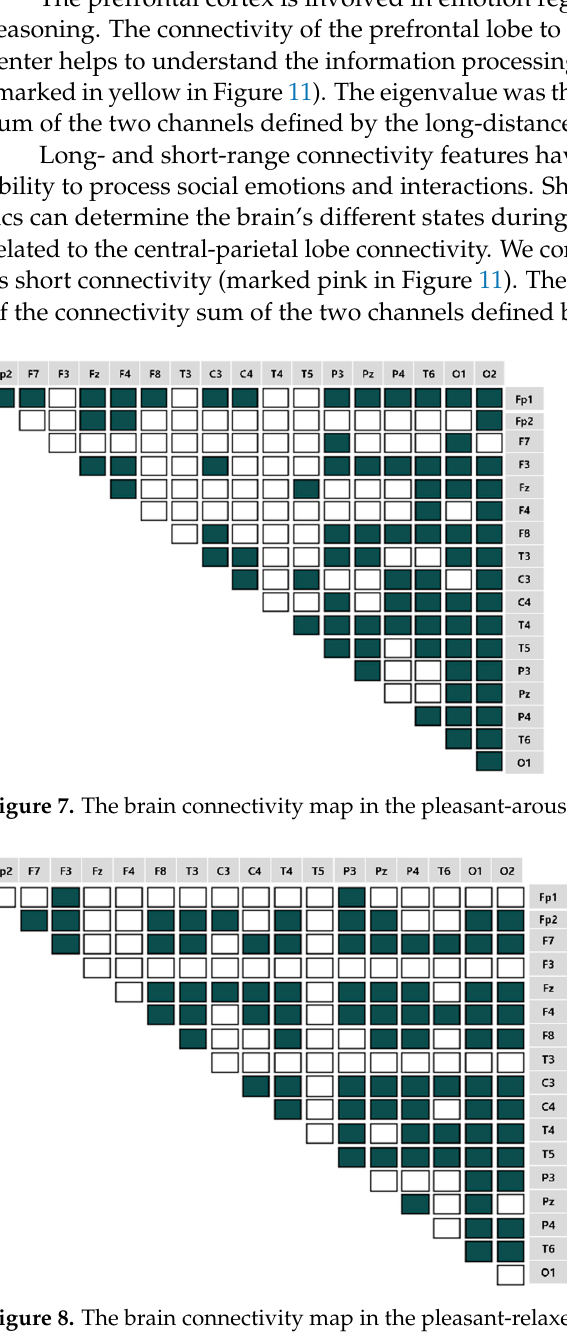
Figure 8. The brain connectivity map in the pleasant-relaxed condition.